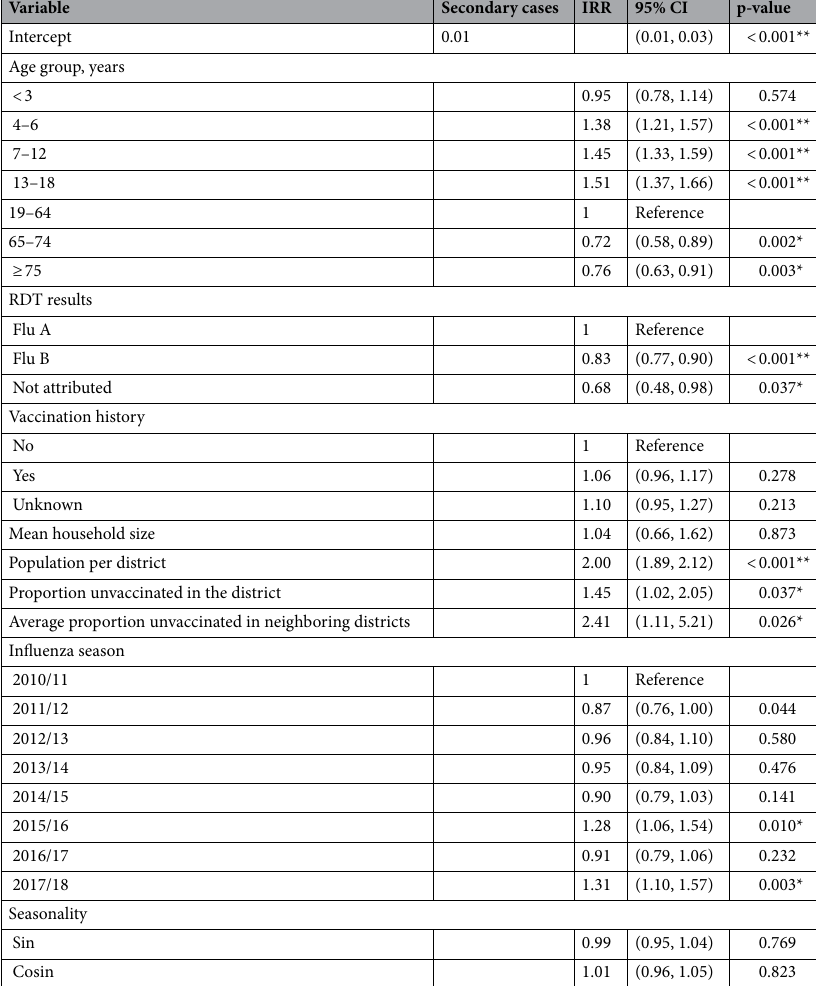
Table 2. Association factors to the number of secondary cases generated, Kamigoto island, Japan, 2010/11– 2017/18. Note: *<0.05;